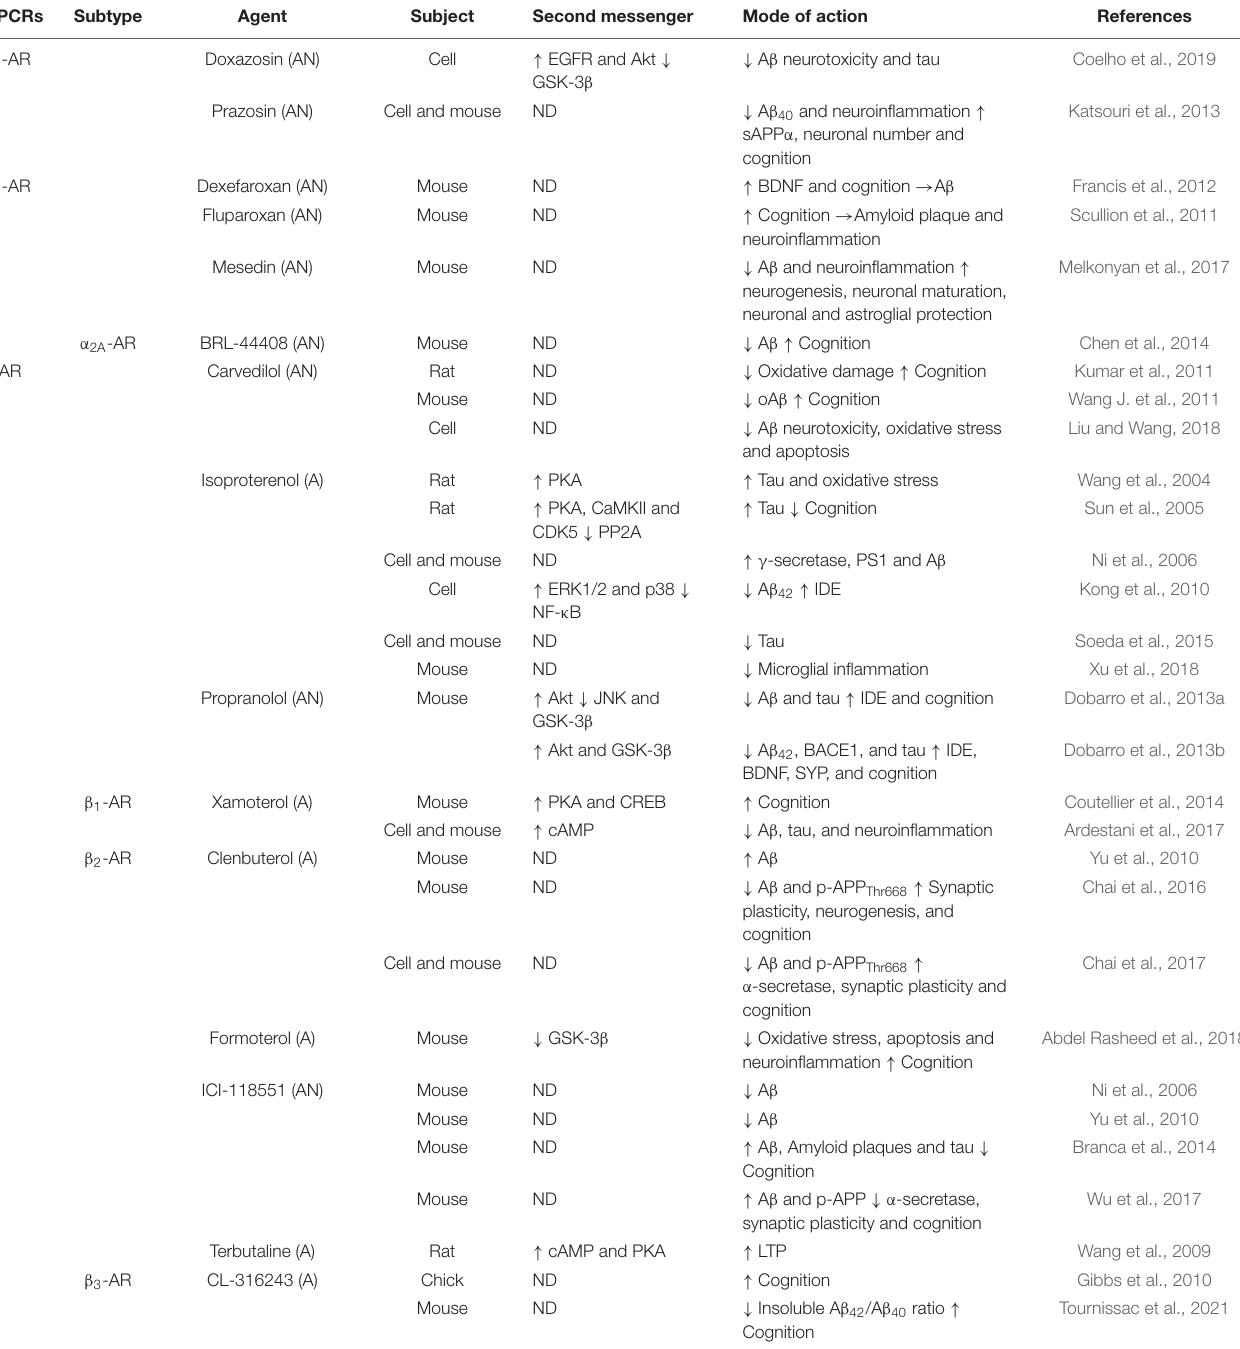
TABLE 2 | Adrenergic receptors reported to be involved in Alzheimer’s